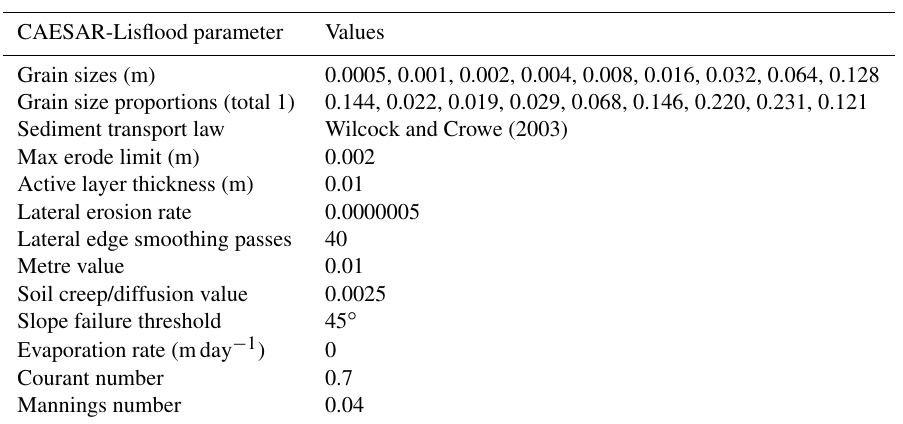
Table 3. CAESAR-Lisflood model parameters used.